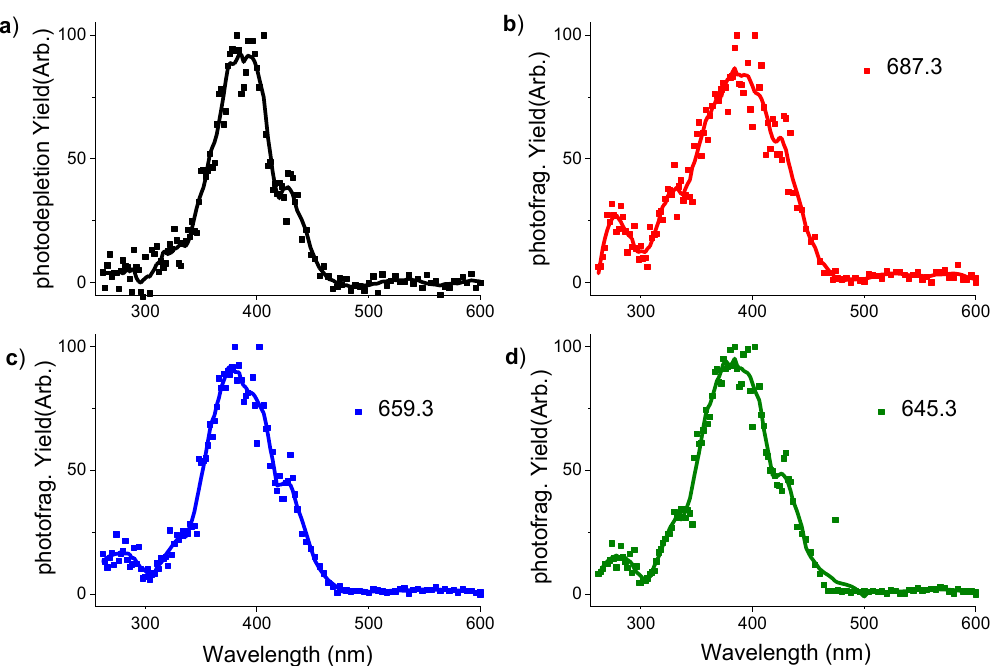
Figure 4. Photodepletion spectra of protonated verteporfin ( a ) and 3 photofragmentation spectra as examples m / z 687.3 ( b ), 659.3 ( c ), 645.3 ( d ). Laser pulse 0.05 mJ (400–260 nm), 0.3 mJ (402–600 nm), and